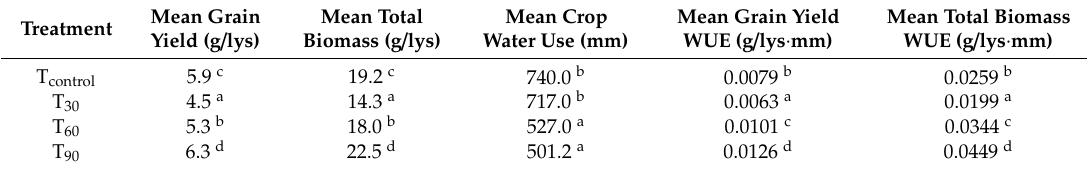
Figure 4. Canola water use efficiency with treatments: ( a ) grain yield water use efficiency (WUE) and ( b ) total biomass WUE. Table 5. Statistical analysis results of the canola’s mean grain yield, total biomass, water use, and water use efficiency.